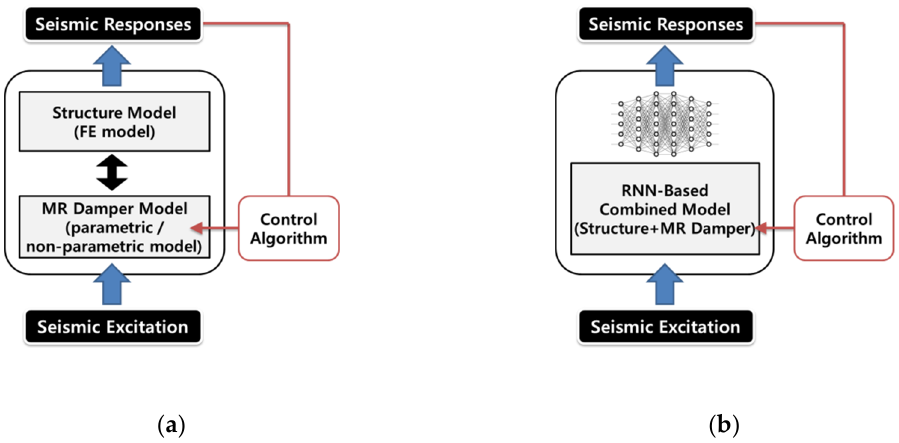
Figure 3. Outline of the seismic response simulation model of a seismic-excited structure with semi-active control system: ( a ) Conventional model; ( b ) RNN-based model.